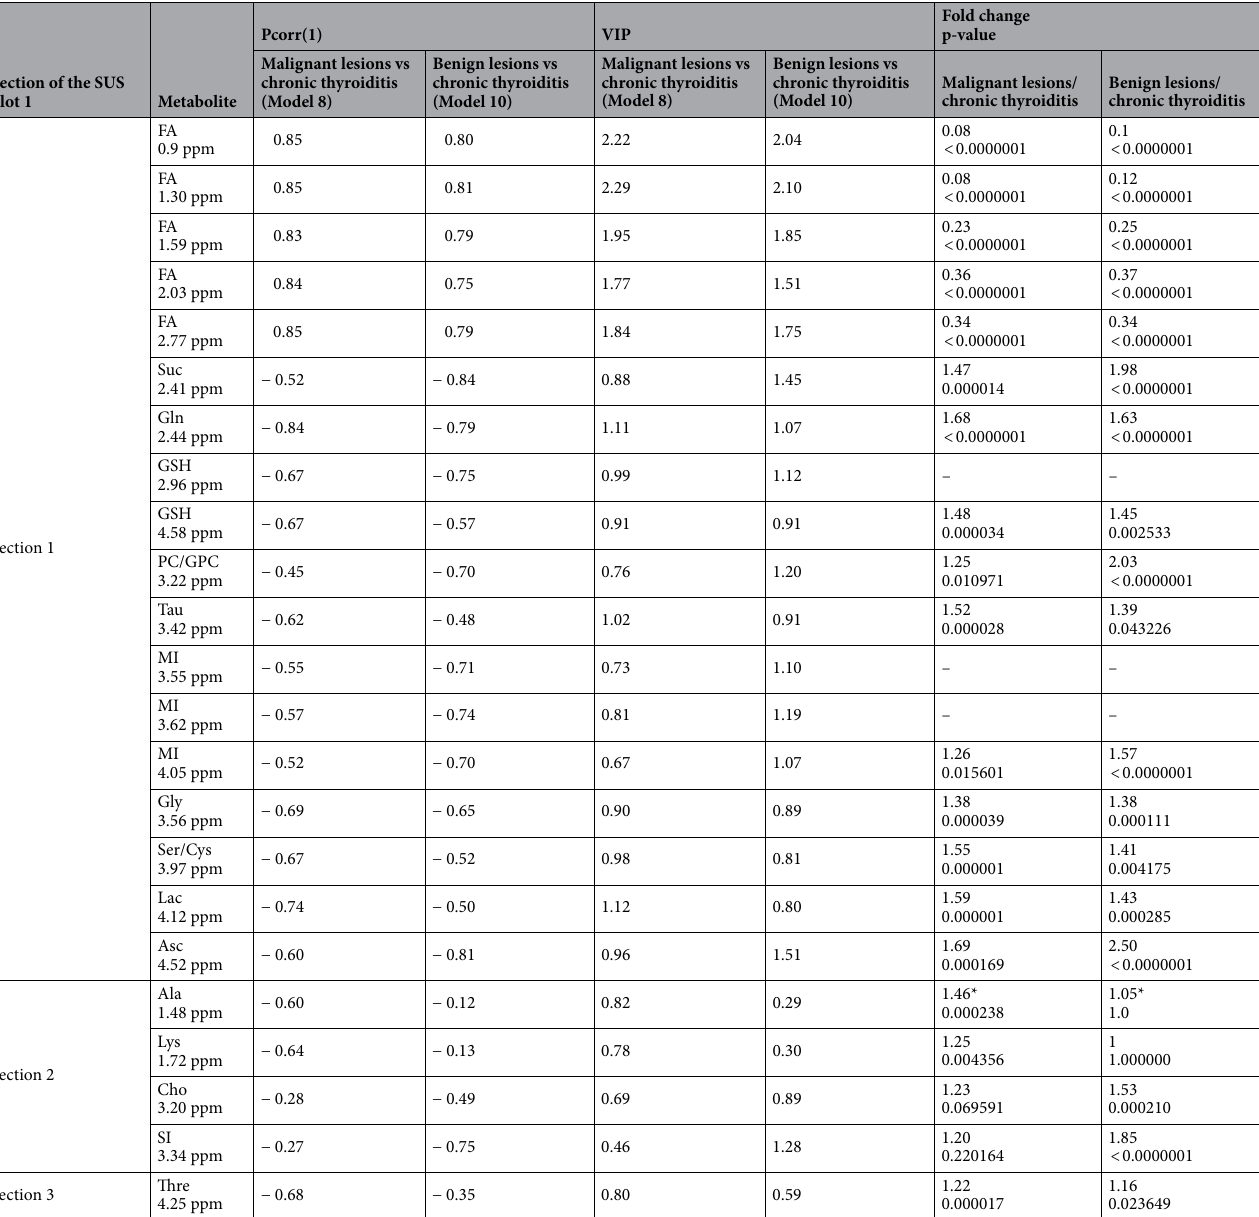
Table 2. The pcorr(1) and VIP values obtained from the OPLS-DA models 8 and 10, as well as the fold- changes (ratios of median metabolite levels in the lesions to the median metabolite levels in non-tumoral tissue) and p values from the univariate analysis (post-host analysis by means of multiple comparisons of mean ranks) for the metabolites contributing to the class separation. Positive (negative) pcorr(1) values indicate a relatively higher (lower) metabolite level in the non-tumoral tissue than in the lesions. *Signal intensites were analyzed instead of signal